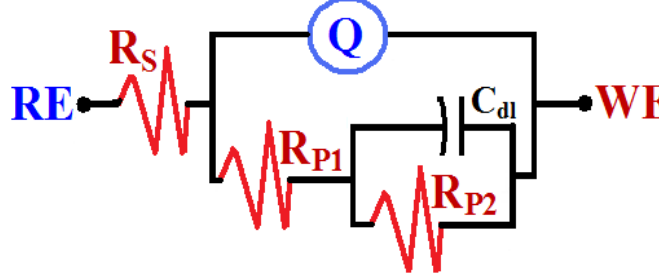
Figure 9. Equivalent circuit model. Table 3. Parameters obtained from fitting impedance data.